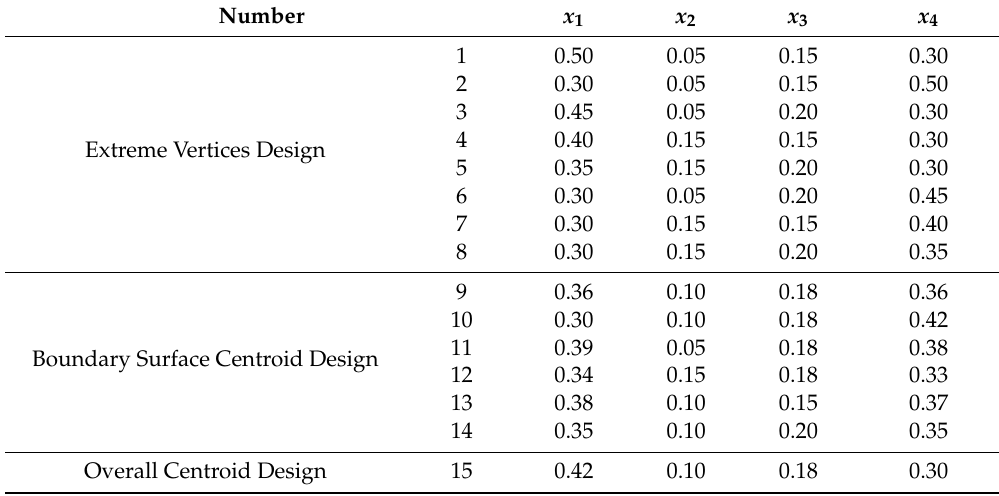
Table 6. Design formula using di ff erent design